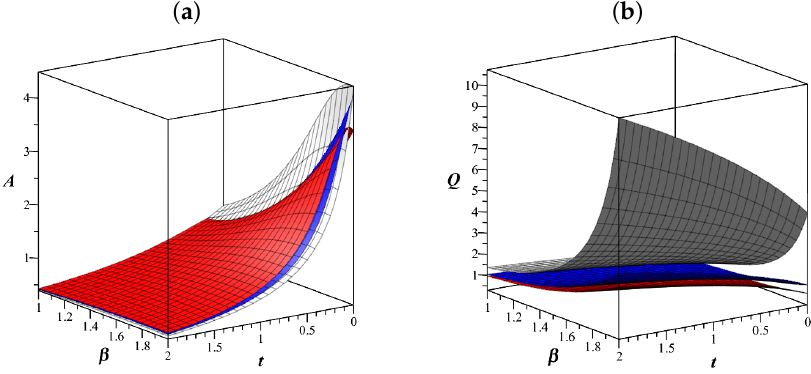
Figure 7. AFC surfaces ( a ) and Q-factor surfaces ( b ) plotted against β and t